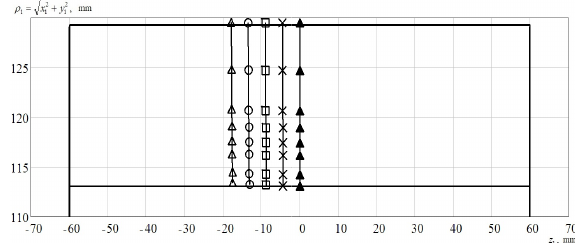
Figure 9. Active lines of action in meshing S δ =0 ( ▲ ); -0,1 ( × ); -0,2( □ ); -0,3( ○ ) and -0,4 mm ( ∆ ) (variant 1)